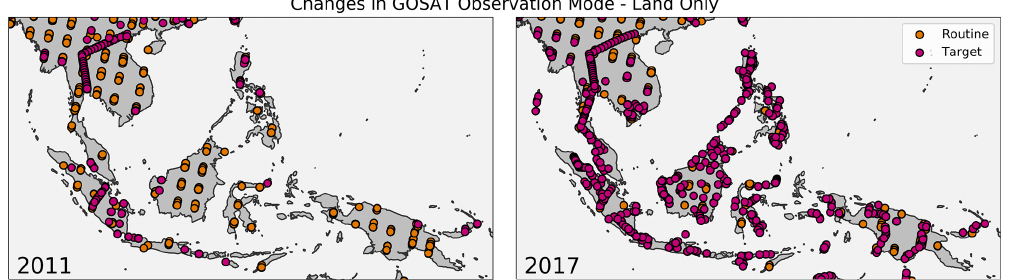
Figure E1. Figure contrasting the routine vs. target observation modes for land-only measurements in 2011 and 2017 over Indonesia. The change in pointing mechanism has allowed a more sophisticated targeting strategy to optimise the number of land measurements over islands and coastlines.